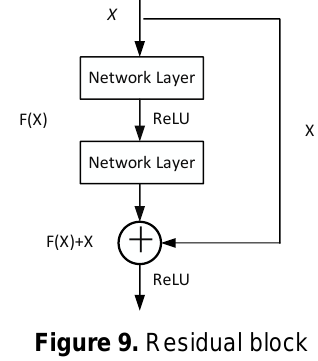
Figure 10. DenseNet